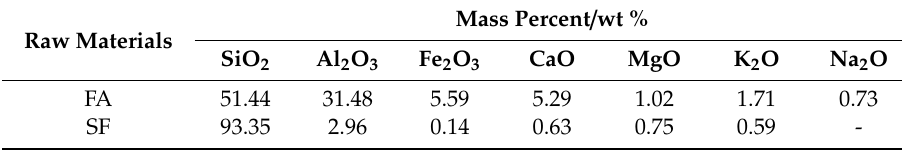
Table 1. The chemical composition of fly ash (FA) and silica fume